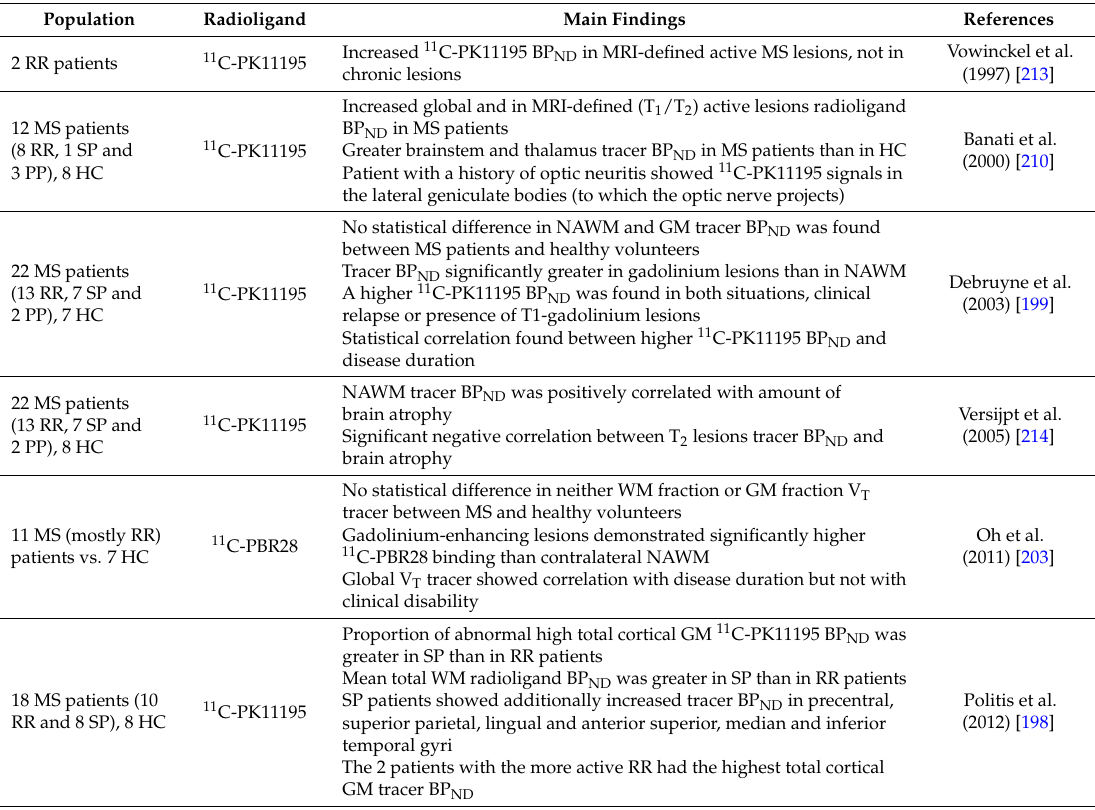
Table 7. PET imaging studies assessing TSPO tracers in multiple